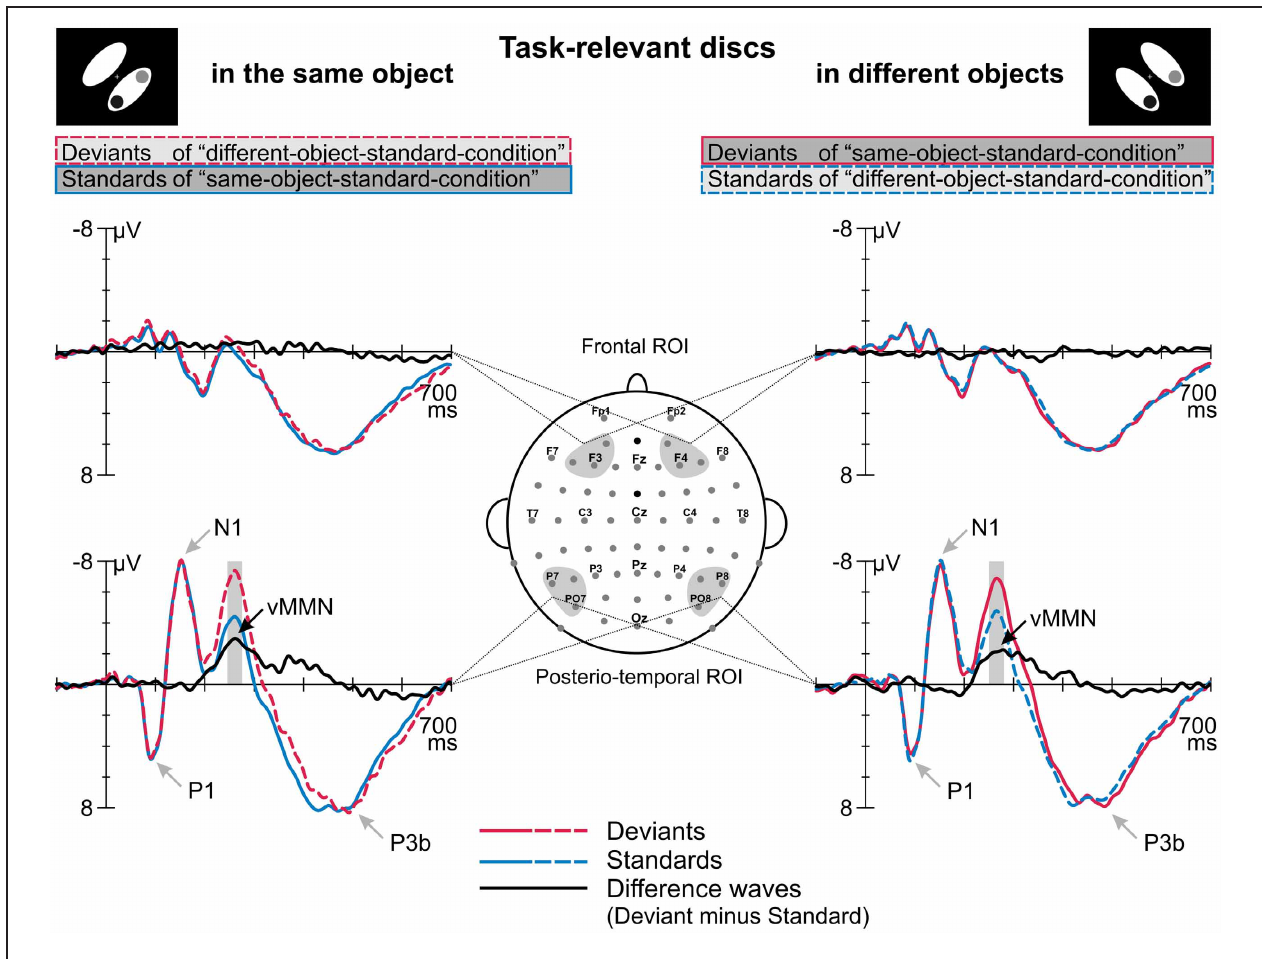
objects). We found differences in the processing of standards and deviants at a posterior-temporal region of interest (ROI, lower row) whereas no such differences occurred at frontal electrode positions (frontal ROI, upper row). Gray shaded boxes indicate the time windows used to determine mean amplitudes which were subjected to statistical analysis. The peaks of prominent ERP components are indicated by gray arrows.